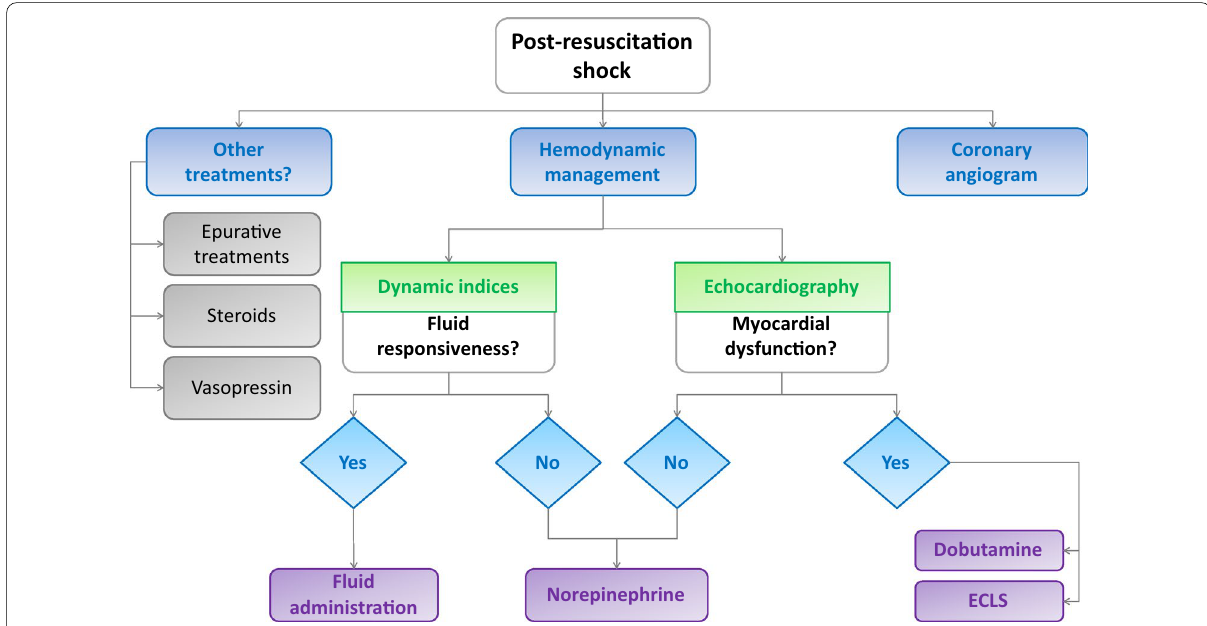
Fig. 2 Proposal for management of post-resuscitation shock. ECLS extracorporeal life